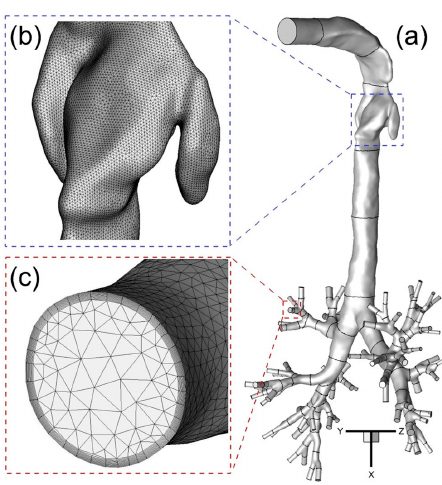
Figure 3. The configuration of subject-specific human upper airway Geometry A from mouth to generation 8 (G8) with tetrahedral mesh including near-wall prism layers: ( a ) Geometry A; ( b ) Surface mesh near the glottis; ( c ) Prism layers at the G6 outlet.